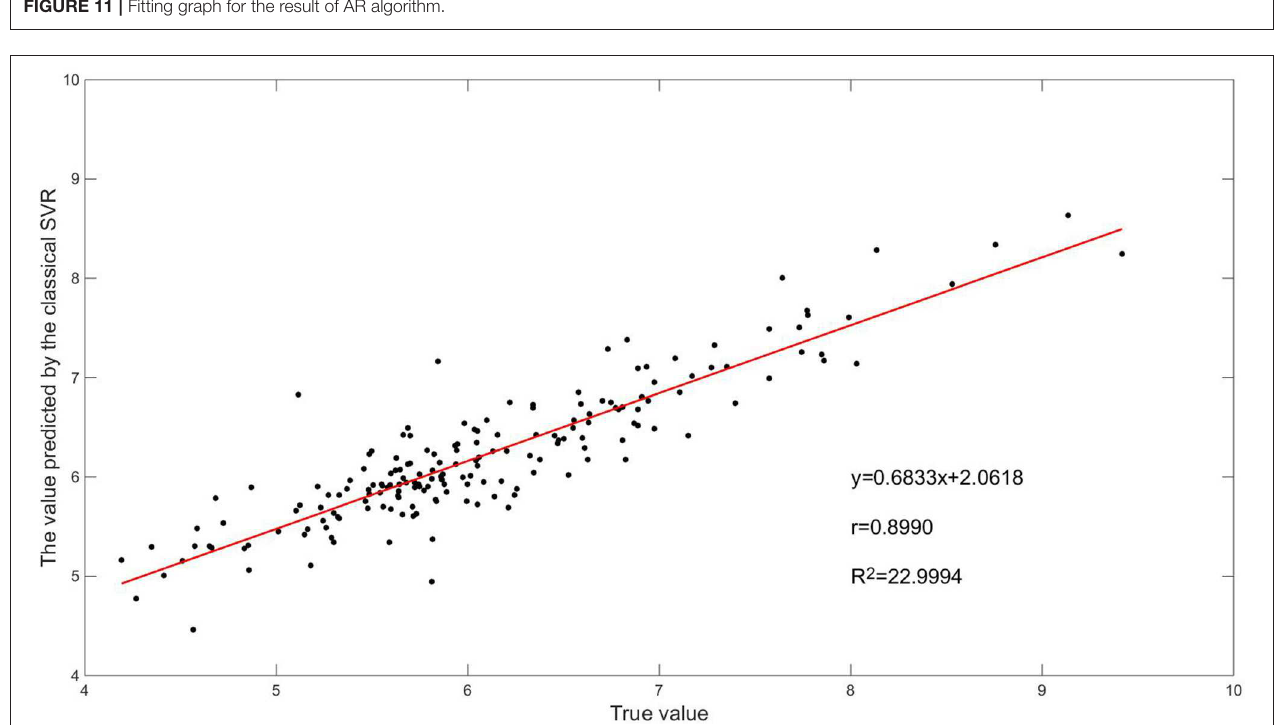
FIGURE 12 | Fitting graph for the result of classical SVR algorithm.